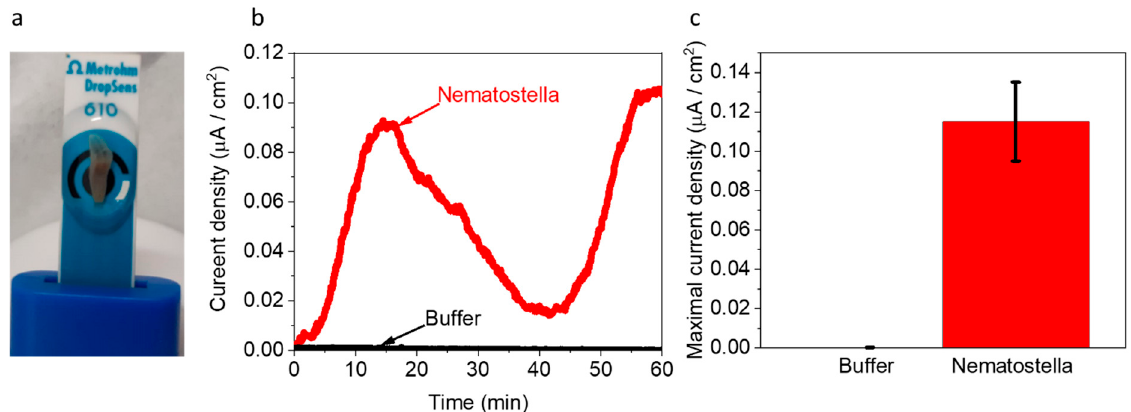
Figure 4. Nematostella produces an electric current in a BEC. Chronamperometry of Nematostella and pure buffer were measured for 1 h using screen-printed electrodes with an applied potential of 0.5 V on the WE. ( a ) A picture of the measurement setup. The Nematostella covers area of 0.31 cm 2 (that is 60% of total WE area). A drop of 100 µL buffer covers Nematostella and the screen-printed electrodes and apply as an electrolyte. ( b ) Chronamperometry of buffer (black) and Nematostella (red). ( c ) Maximal current density of buffer (gray) and Nematostella (red). The error bars represent the standard deviation over three independent repetitions.